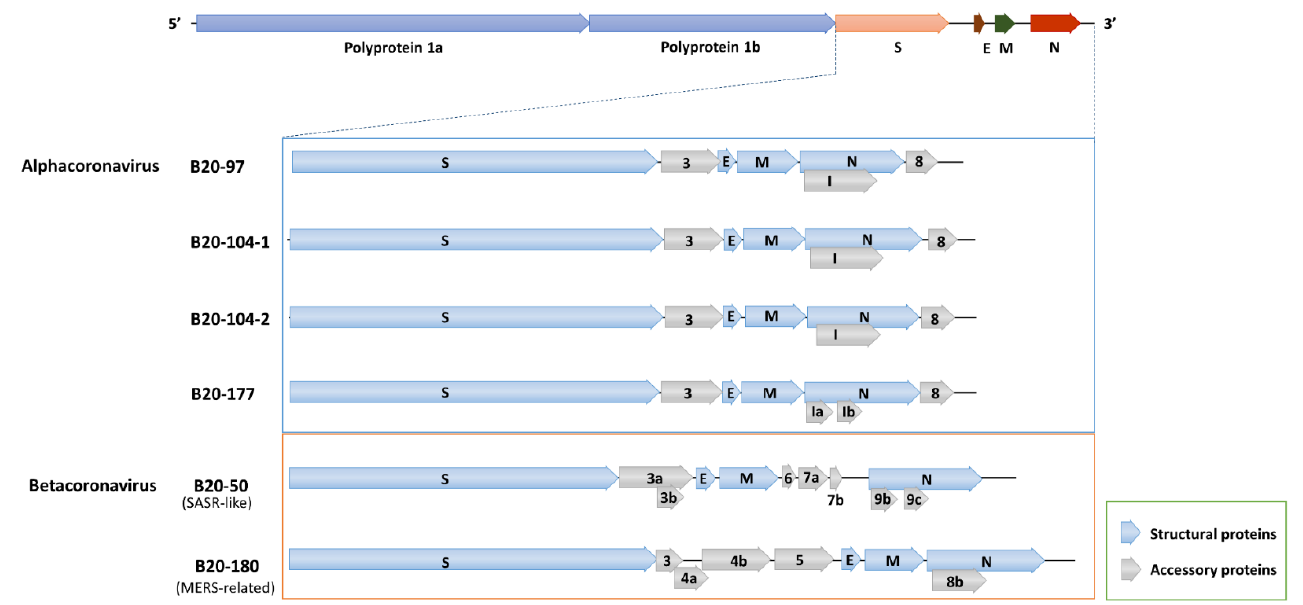
Figure 1. Genome organization of six strains. The general genomic structure is depicted at the top. The expanded regions below show the structural and accessory protein in the 3′ regions of the αCoVs (B20-97, B20-104-1, B20-104-2, and B20-177) and βCoVs (B20-50 and B20-180). The expanded regions are drawn to scale. Table 2. Putative transcription regulatory sequences (TRS) of six genome sequences (distance base to